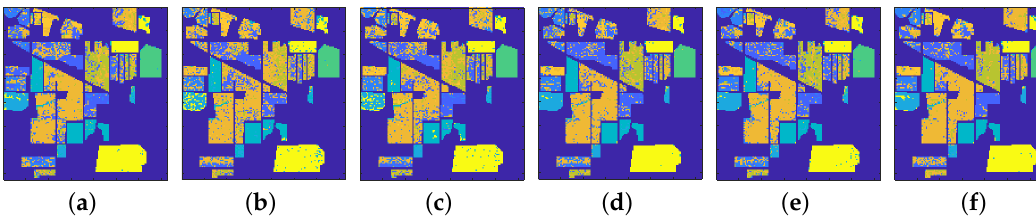
Figure 5. SVM classification maps of using the fifteen bands selected by different methods from the